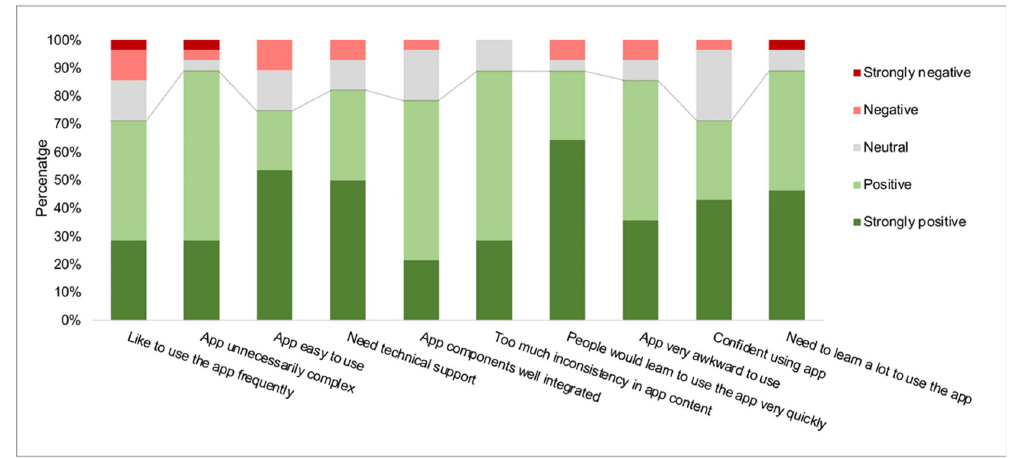
Fig 6. Feedback to system usability scoring items (Step 2 unmoderated field testing). The response to each item of the System Usability Scoring is converted to a scale from strongly negative to strongly positive. Across the ten items, the responses from more than 70% of the participants are positive (positive and strongly positive), indicating the well-perceived usability of AICaries app. For example, 70% of the participants like to use the app frequently and feel confident using the app; less than 10% of the participants feel they need technical support in order to use the